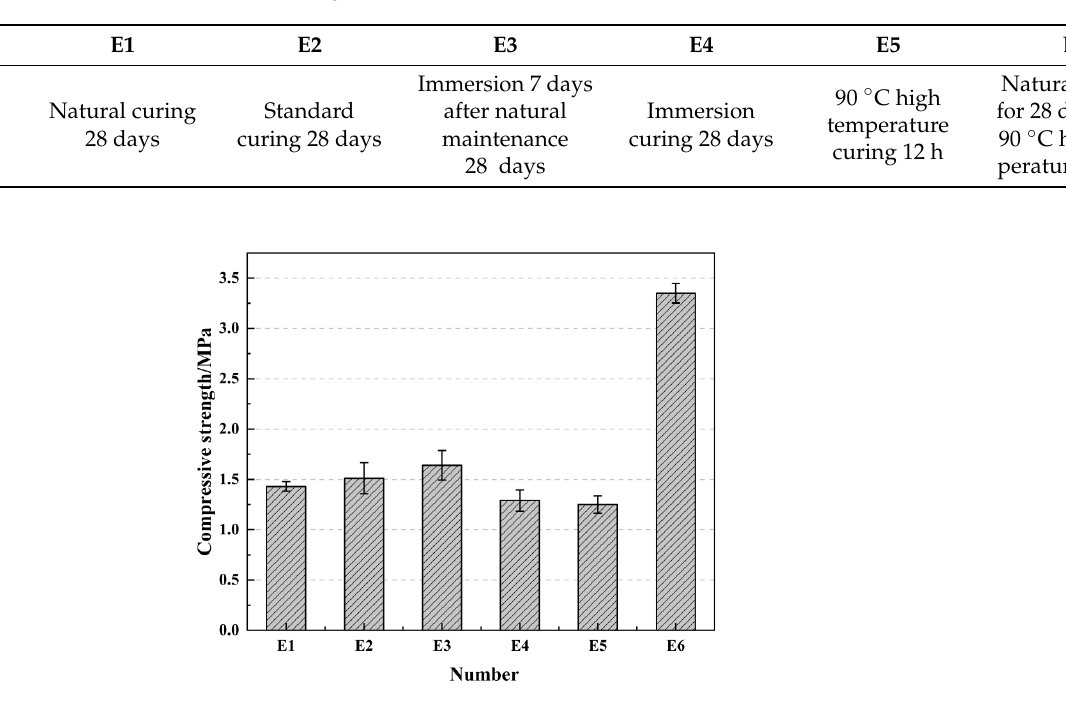
Figure 5. Compressive strength under different curing conditions.